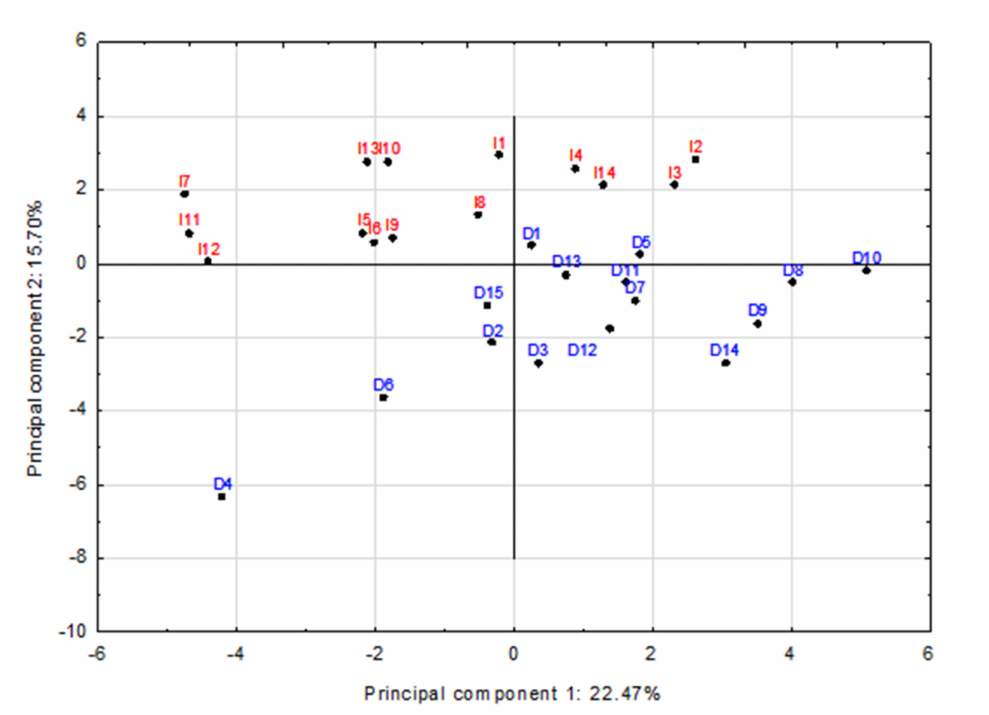
Figure 3. Score plot of the principal component analysis of the sensory attributes and mould species of “Istarski pršut” (I) and “Dalmatinski pršut” (D)